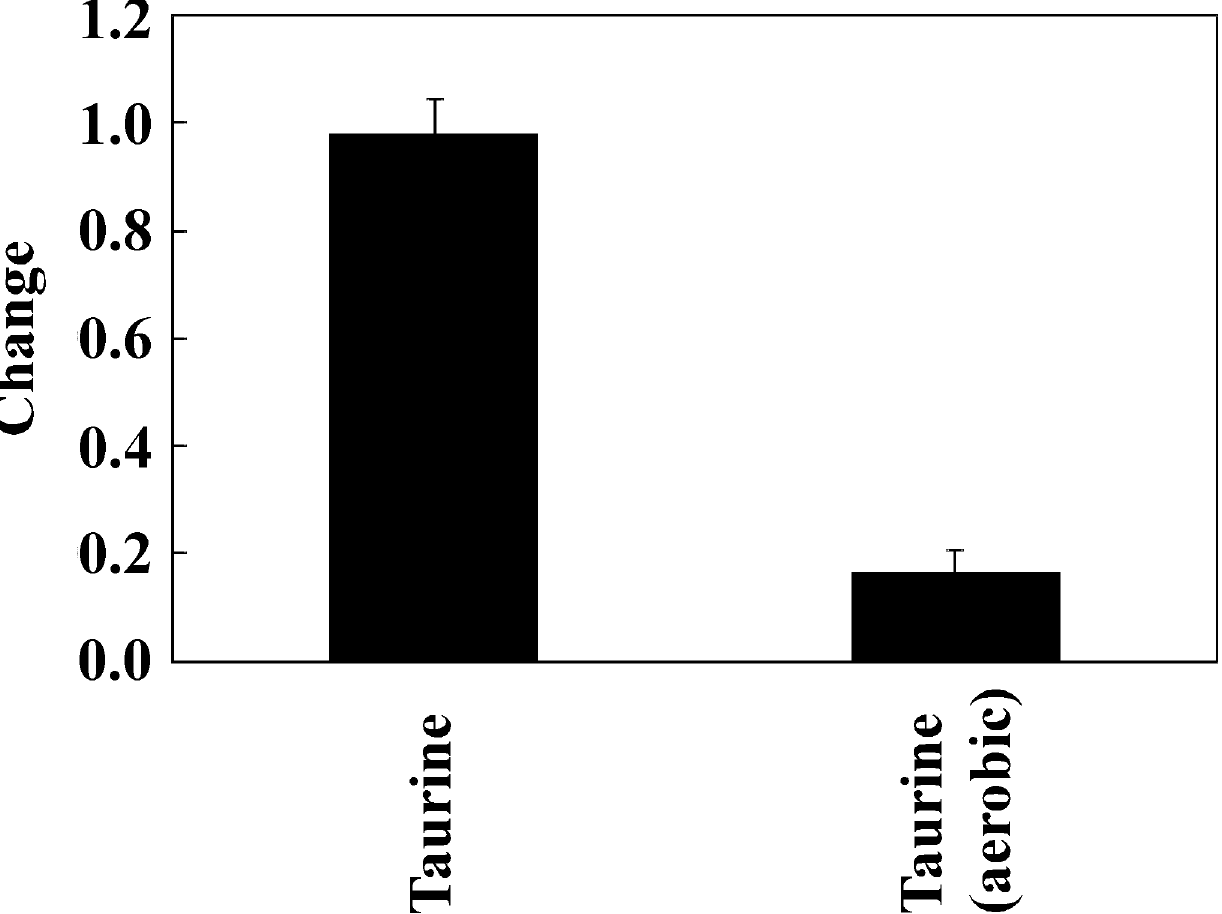
Fig 1. Changes in concentrations of taurine in the Kobe University Human Intestinal Microbiota Model (KUHIMM) cultures. “Change” indicatesthe ratio of the concentration at 30 h after the initiation of fermentation to the starting concentration (about 10 mM). Fermentation was initiated by inoculating separate cultures with one of each of the human fecal samples (M39, M38, F40, M43, M60, F62, M25, and M34). In addition, changesin taurine concentration were investigatedunder aerobicconditionsin the KUHIMM followinginoculationof 4 separate cultures with one of each of 4 of the humanfecal samples (M39, M38, F40, and M34).